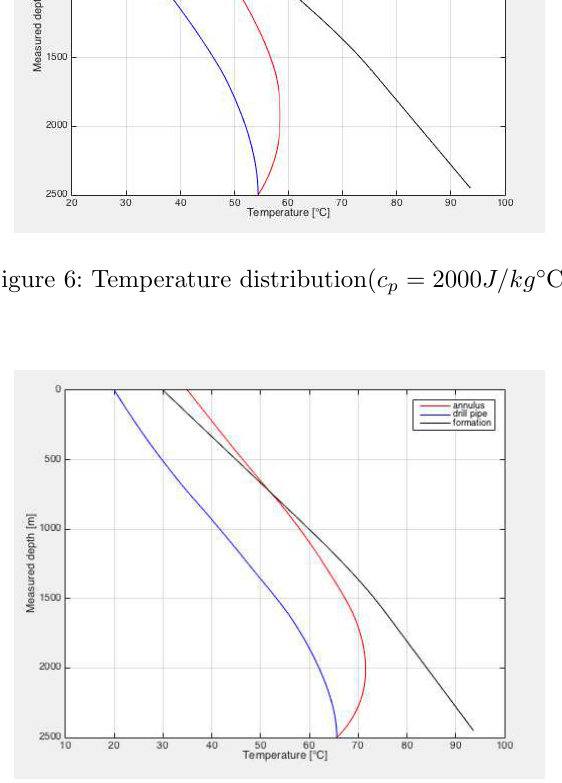
Figure 7: Temperature distribution( c p = 2000 J/kg ◦ C, Q = 500 l/min )